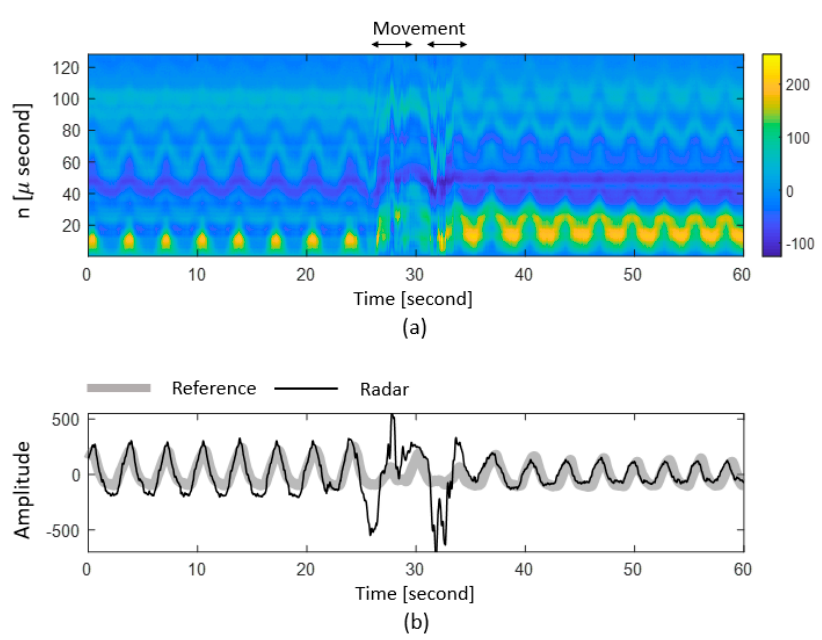
Figure 1. Measured respiratory signals. ( a ) Radar signal, ( b ) respiratory signal measured by radar at a specific range bin and from actual breathing .